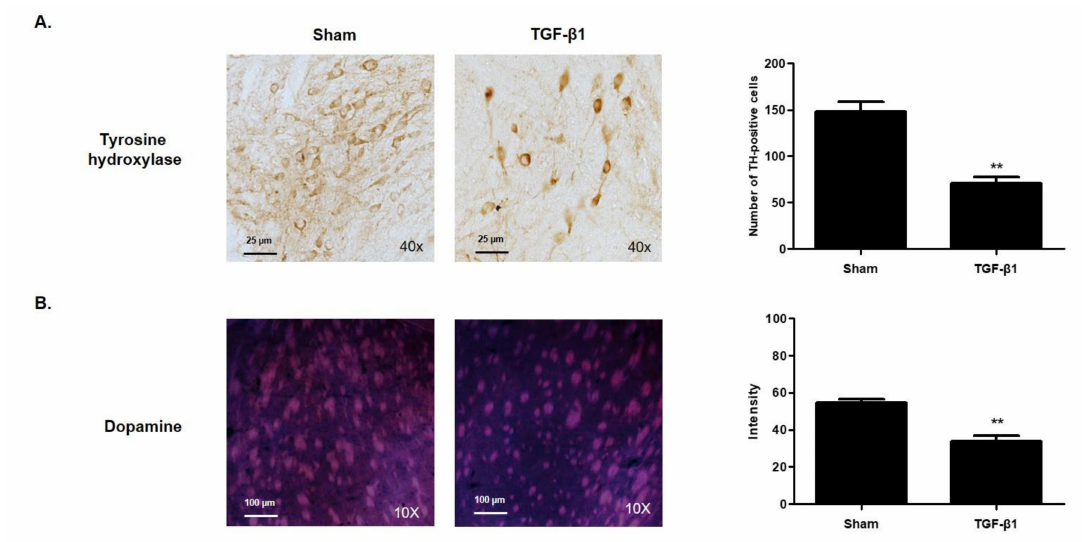
Figure 4. Effects of TGF- β 1 on dopaminergic system. The brain was isolated from C57BL/6 mice at 18 days after TGF- β 1 i.c.v. injection. ( A ) The level of tyrosine hydroxylase (TH) in the ventral tegmental area was observed using immunohis- tochemistry staining. ( B ) Dopamine in the striatum was identified using immunofluorescence staining. Representative photomicrographs were taken at magnifications of 40 × and 10 × . ** p < 0.01 compared with the sham group.